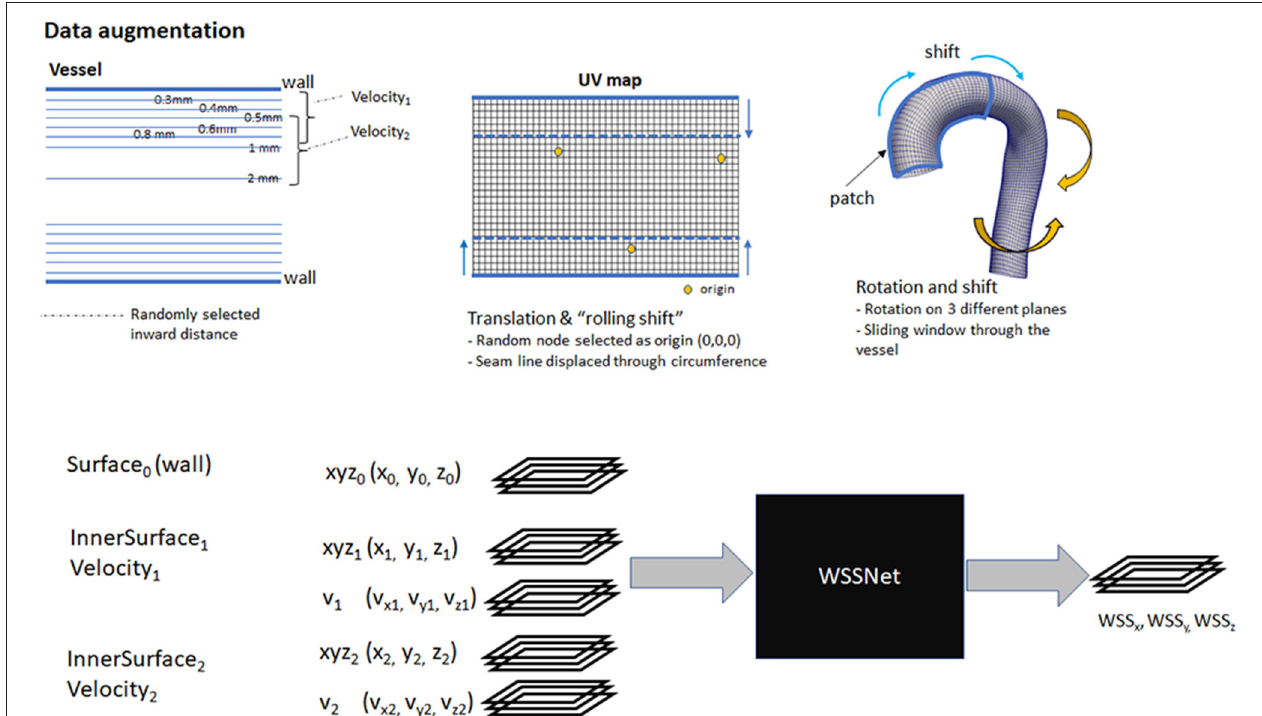
FIGURE 5 | Top: Overview of augmentation strategies. Velocity sheets were extracted at various distances from the surface (0.3–2.0mm). During training, two velocity sheets were chosen randomly, with the first one closer to the vessel than the other. Bottom: a global overview of the input and output of WSSNet. Input consists of 15 channels, consisting of 3 coordinate flatmaps and 2 velocity sheets. The output consists of 3 channels, correspond to wall shear stress vectors in Cartesian